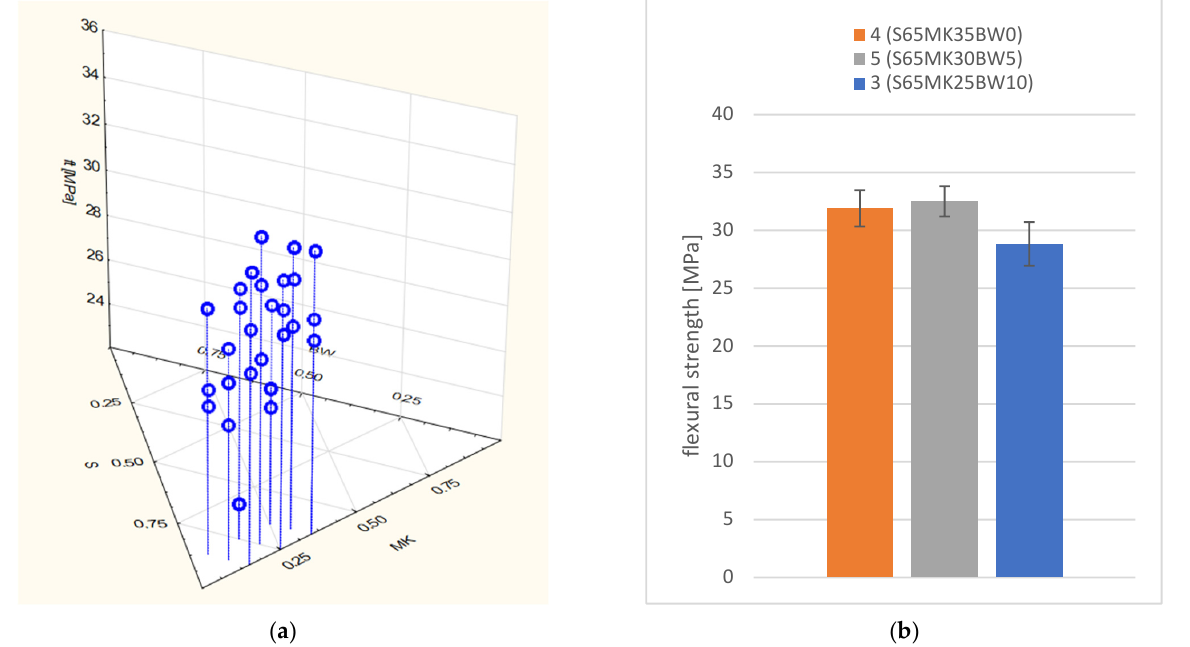
Figure 7. Flexural strength of the tested composites: ( a ) dependence in the experimental plan; ( b ) dependence on biochar content.